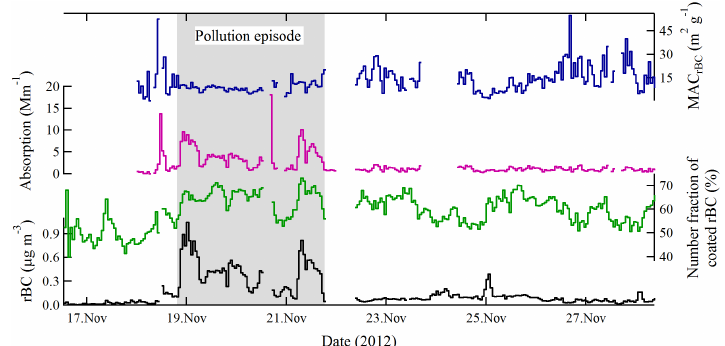
Figure 2. Time series of the rBC mass concentration, number fraction of coated rBC, light absorption at λ = 532nm, and mass absorption cross section of rBC (MAC rBC ) during the entire campaign period. The pollution episode is highlighted with the gray background.